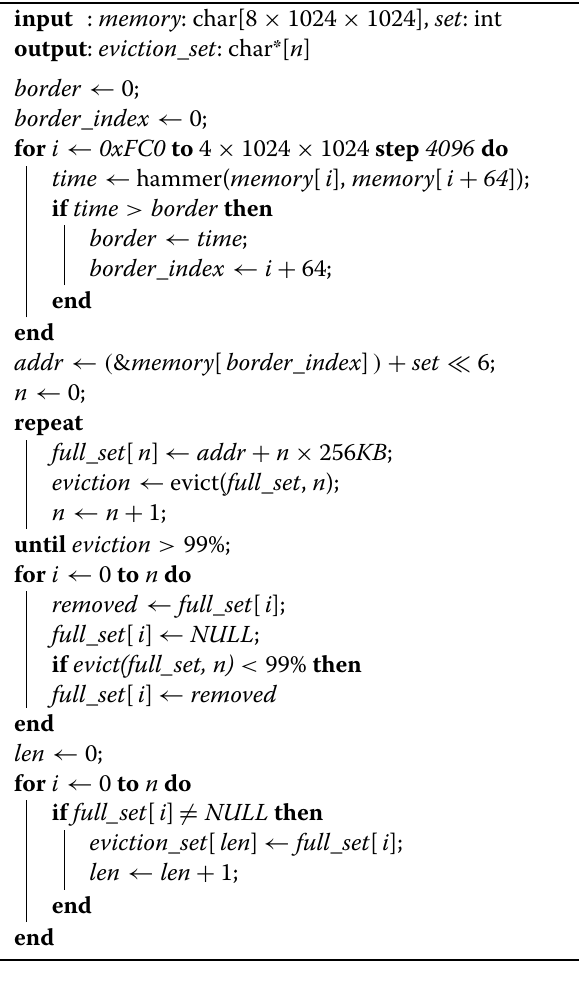
Algorithm 2: Generating the eviction